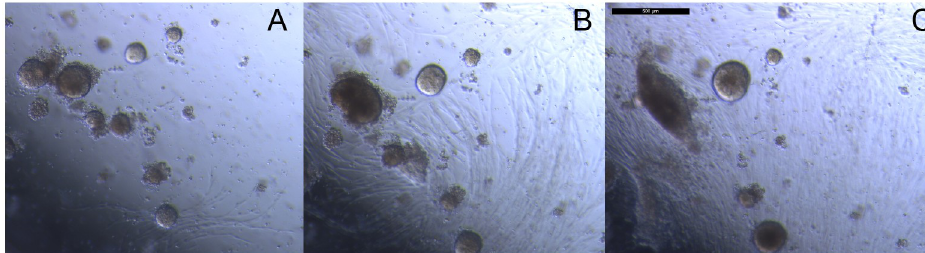
Fig 6. Bright field images of Tumor 11 shows multiple cell types and movement over time. Images collected at (A) Week 4, (B) Week 5, and (C) Week 6. The scale bar (C) is 500 μ m.